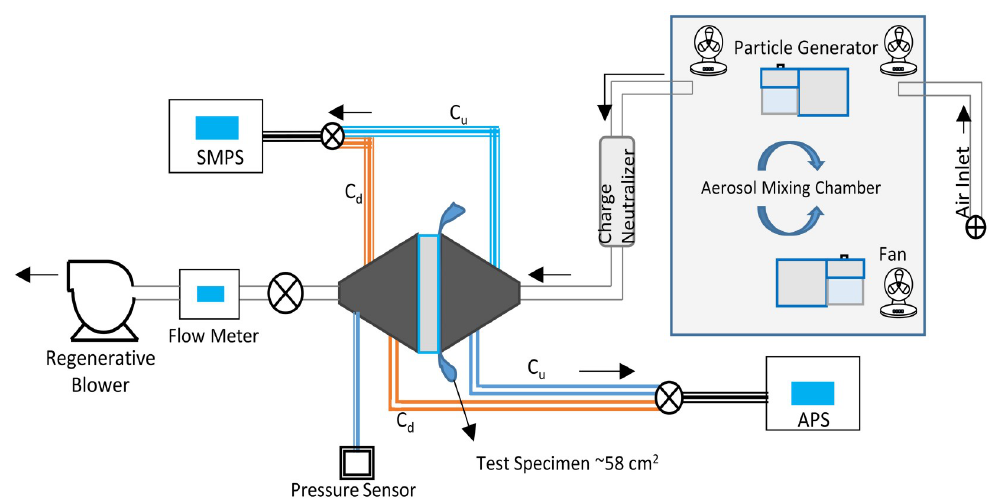
Fig 2. Schematic of aerosol swatch penetration set-up. A polydisperse NaCl aerosol is generated in the mixing chamber and pulled through the charge neutralizer and swatch test rig using a regenerative blower. Air flow is regulated using the flow meter. Aerosol concentration, upstream and downstream, is measured with the SMPS/APS as